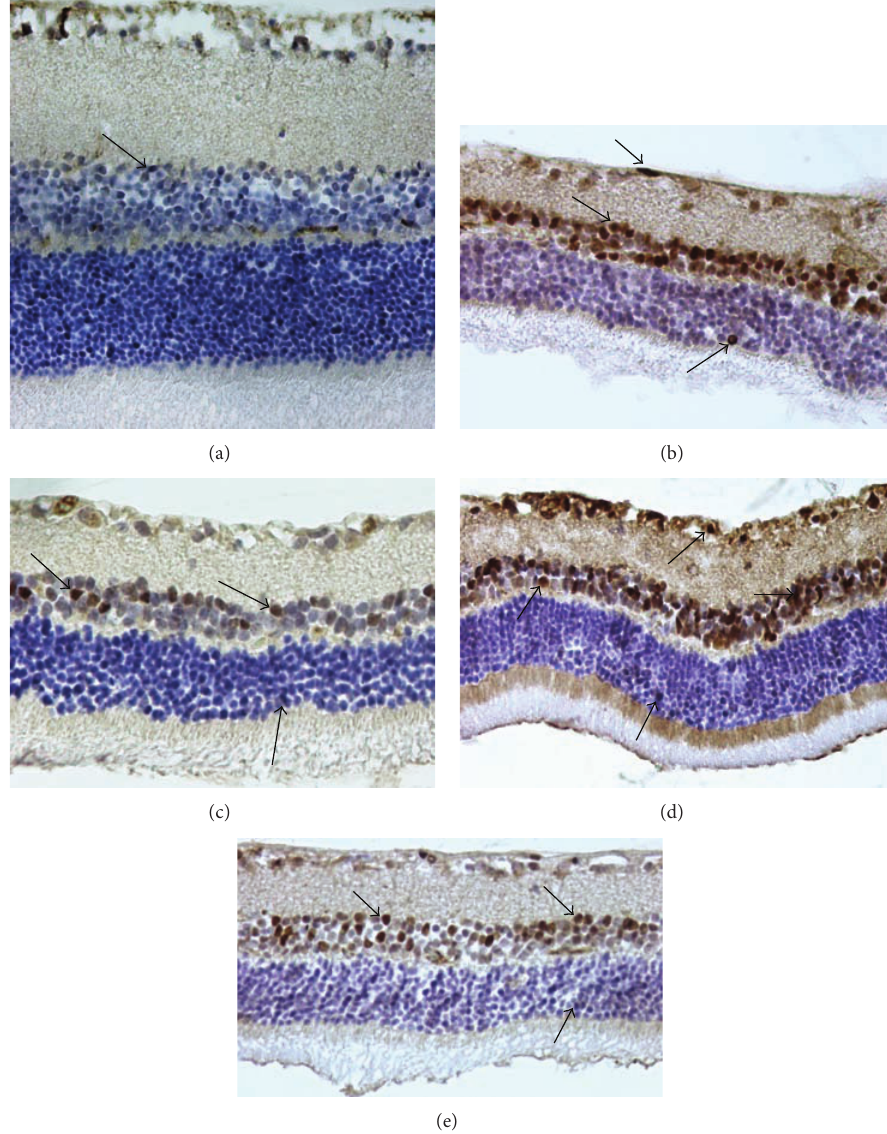
Figure 2: Caspase 3. (a) Control group, a few caspase 3-positive cells; (b) ischemic group; (c) ischemic injury plus DMSO group; (d) ischemia plus hesperetin-treated group, and (e) ischemia plus naringenin-treated group. At the end of the experiment, fewer caspase 3-positive cells were noted in the hesperetin- and naringenin-treated groups than those in the ischemic retinal cells. Arrows: Caspase 3-positive cells. Immunoperoxidase, hematoxylin counterstain ( ×